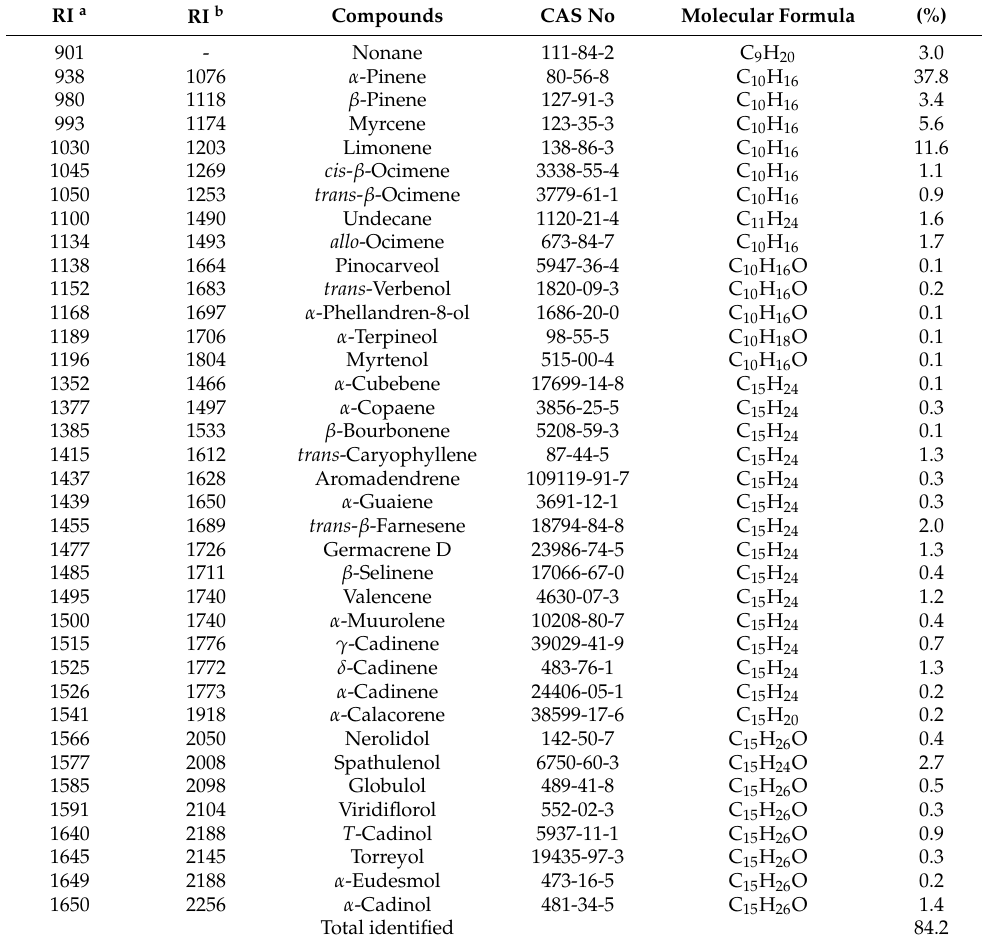
Table 1. Chemical composition of Hypericum scabrum essential oil (EO).